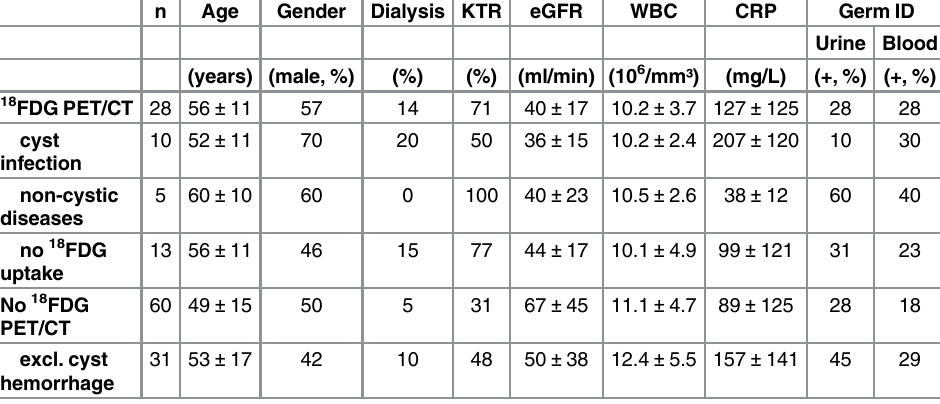
Table 3. Clinical and biological characteristics of the cohort upon 18 FDG PET/CT